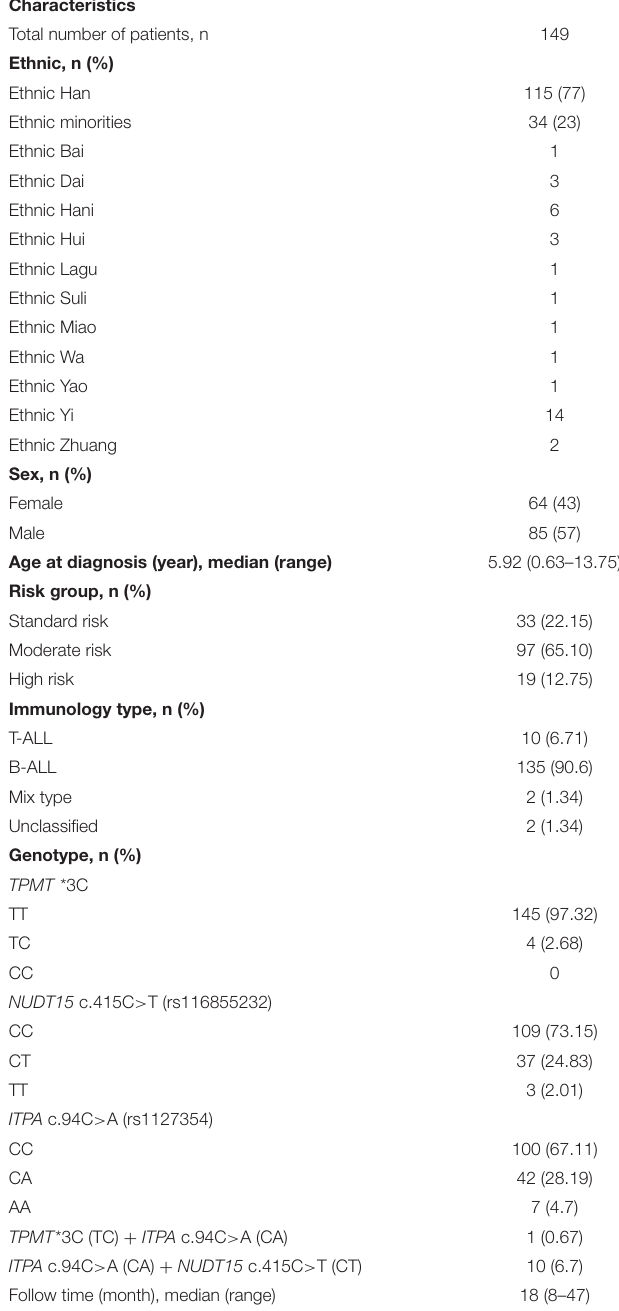
TABLE 1 | Baseline characteristics of patients and genotype